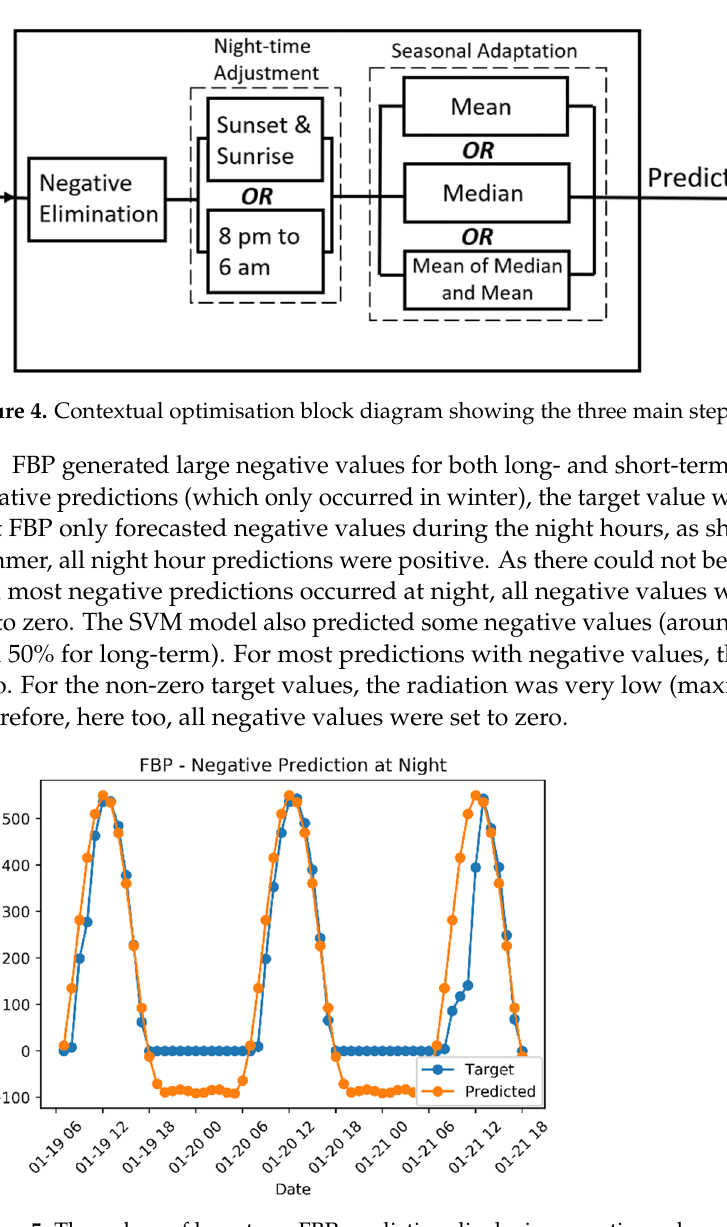
Figure 6. FBP, displaying overprediction in morning and evening and underprediction at noon. For the seasonal adaptation, for every hour of the day within each month (e.g., the 6th hour of every day in January), all values from previous years were collected. The av- erage of these target values for the particular hour was taken for each month, as shown in Figure 7. The same was carried out for the predicted values. Three different versions of